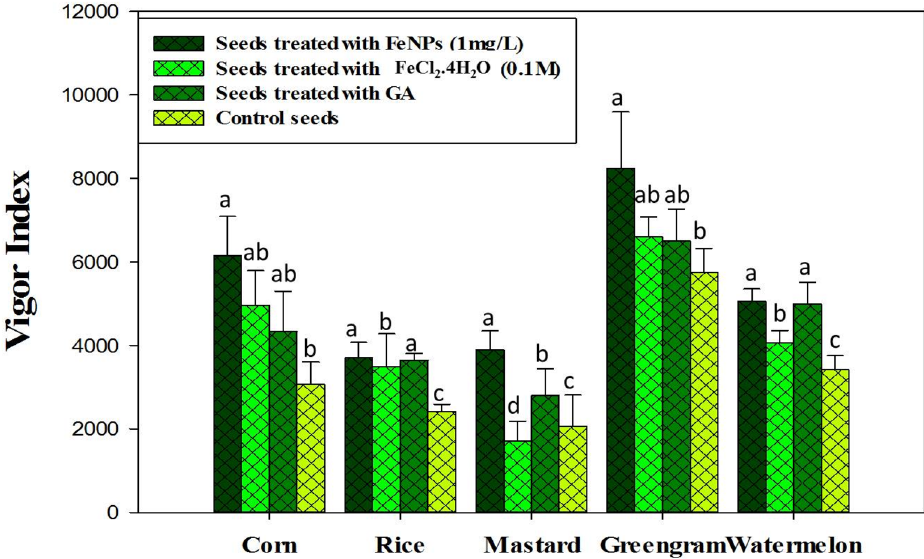
Figure 5. Effect of Fe 3 O 4 -NPs, bulk FeCl 2 .4H 2 O (0.1 M), and Gibberellic acid on Vigor index of the tested crops. Values in each bar are represented as mean ±